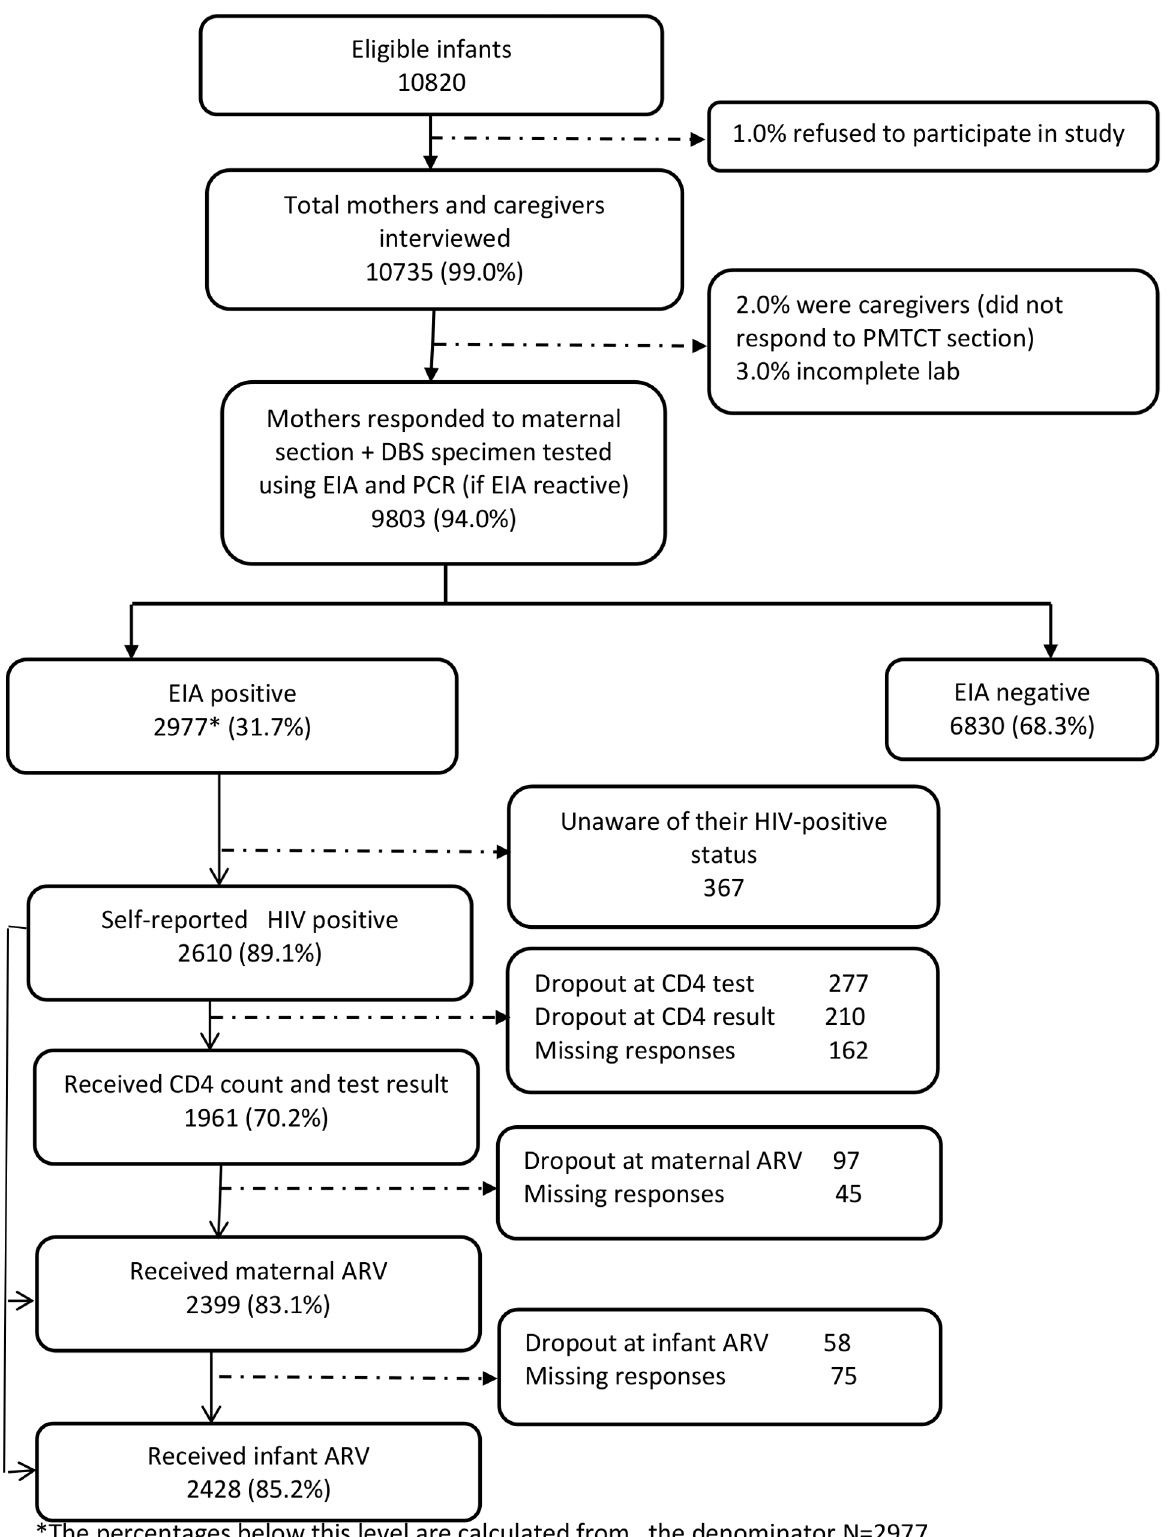
Fig 1. 2010 PMTCT cascade Study Profile.